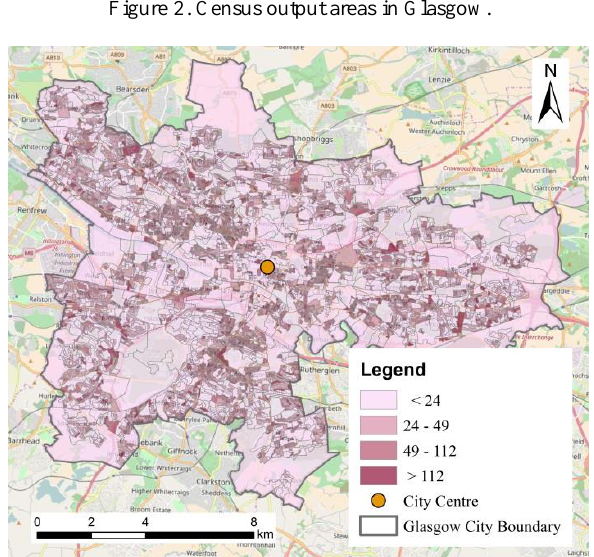
Figure 3. Density of daytime population in Glasgow